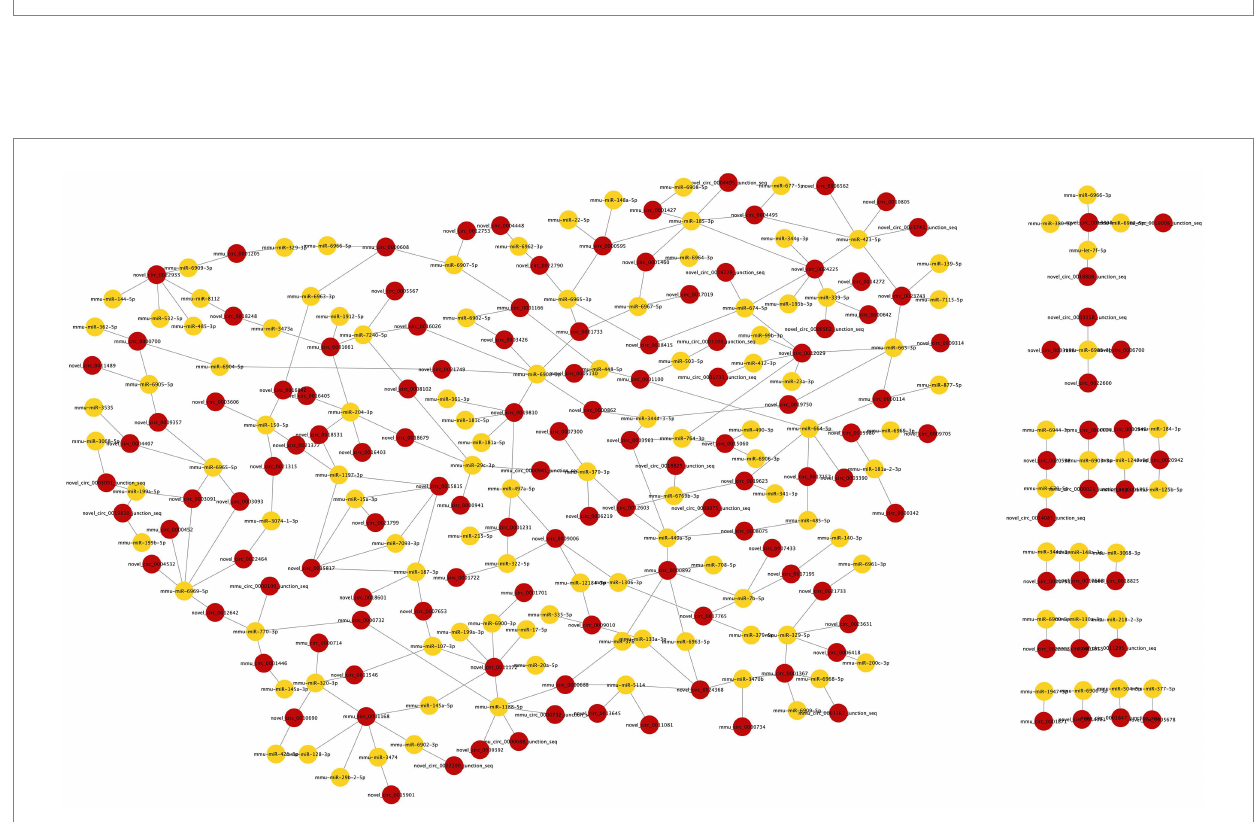
FIGURE 4 The DEcircRNA–DEmiRNA regulatory network in postoperative period. Circles in red represent DEcircRNAs and circles in yellow represent DEmiRNAs. 98 DEcircRNAs were predicted to bind 95 DEmiRNAs with 190 pairs of